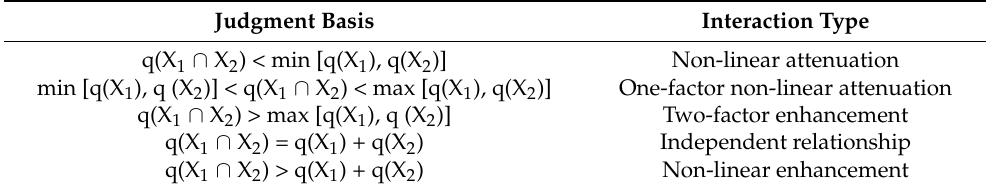
Table 2. Types of